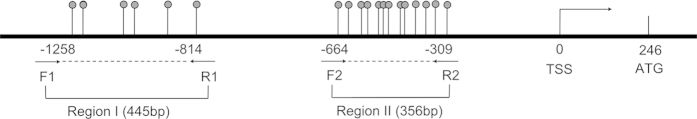
Schematic representation of the two regions of the EGFR promoter. The successful genotyping CpG sites are indicated with lollipop markers and some CpG sites were detected together. The forward and reverse primers are shown with arrows below the diagram. TSS: transcription initiation site.